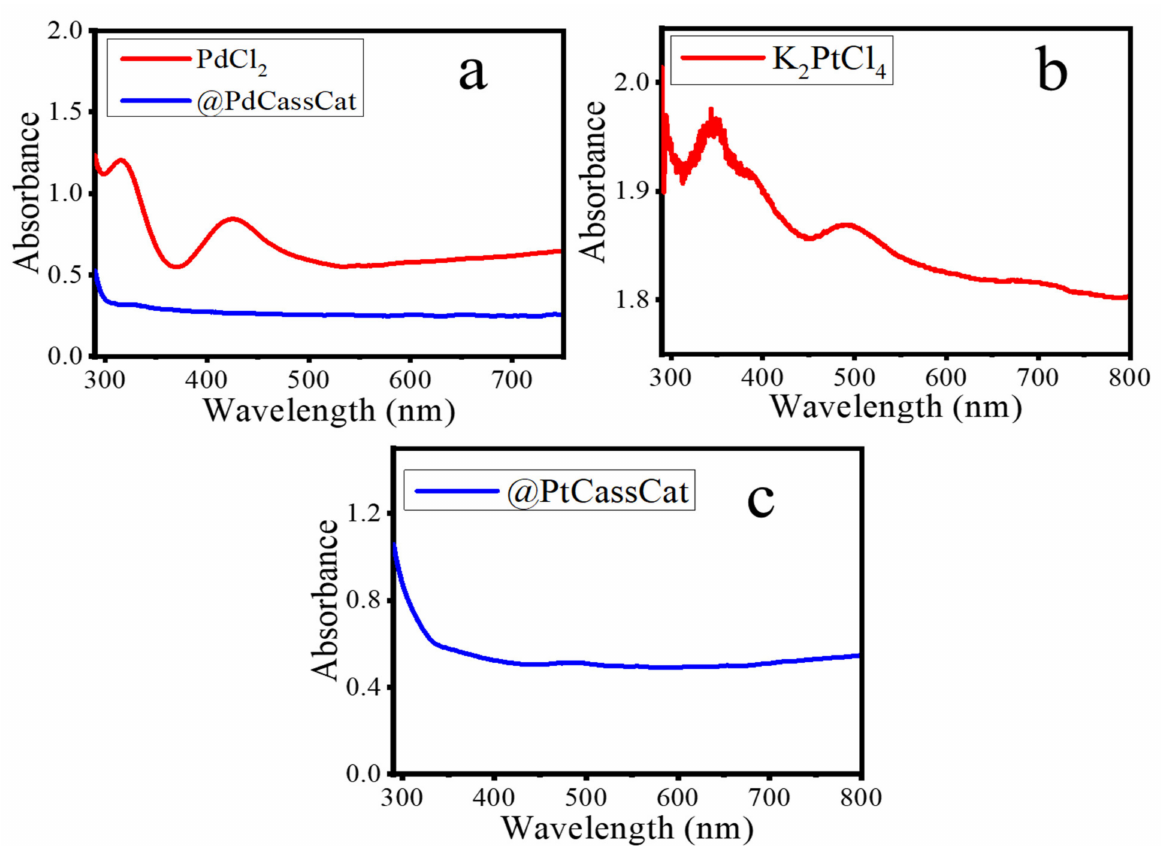
Figure 7. UV-Vis absorption spectra of ( a ) PdCl 2 and Pd NPs in @PdCassCat ( b ) K 2 PtCl 4 and ( c ) Pt NPs in @PtCassCat.